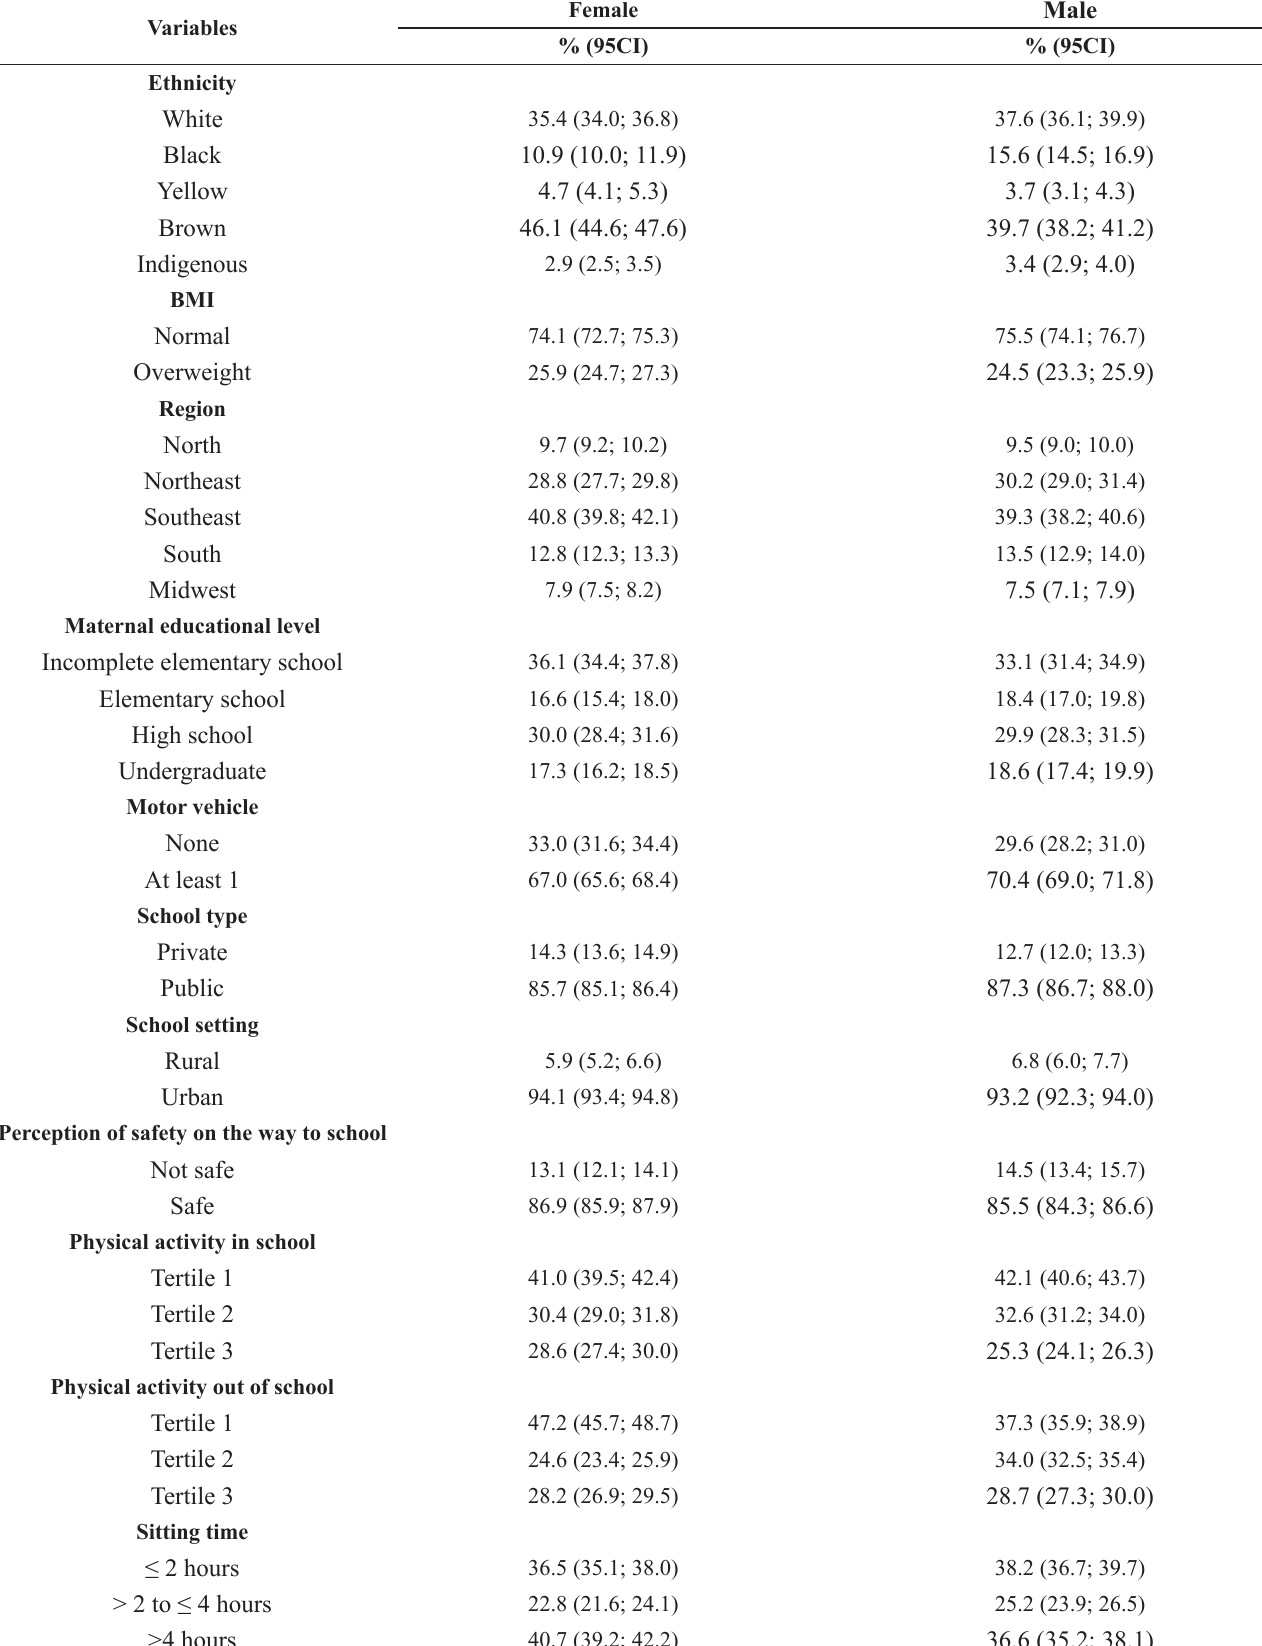
Table 1- Sample characteristics by sex (n